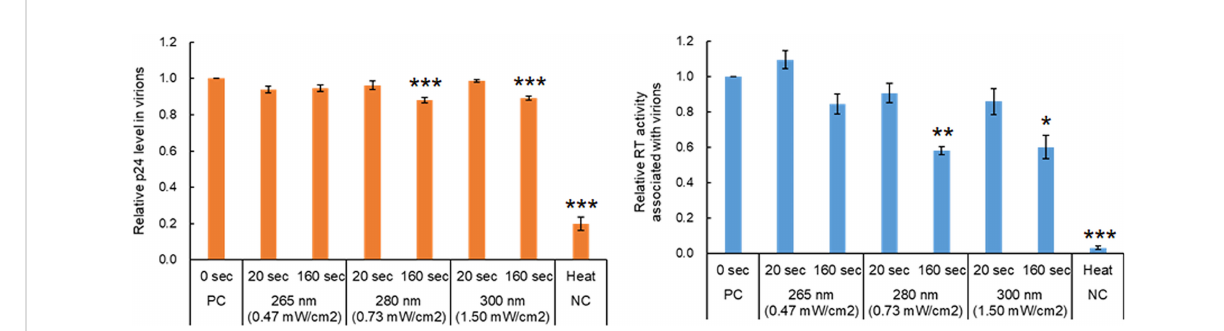
FIGURE 3 Effect of UV-irradiation with various wavelengths on HIV-1 proteins in virions. Viruses were prepared from HEK293T cells transfected with proviral clones. Virus stocks with and without heat-treatment were diluted as described in Figure 1. The diluted samples were exposed to UV at three wavelengths for the indicated time periods, and then were subjected to p24 ELISA and RT assays. The relative p24 level (left) and RT activity (right) in each sample to those in the sample without any treatment are presented. Mean values with SE are shown (n=4). Signi fi cance relative to the sample without any treatment as calculated by Welch ’ s t test is shown (*P < 0.05; **P < 0.02, ***P < 0.01). PC, positive control; NC, negative